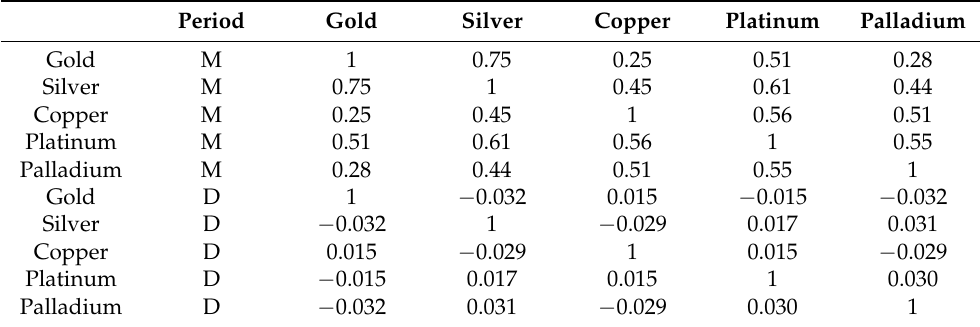
Table 1. Correlations matrix of monthly and daily returns.